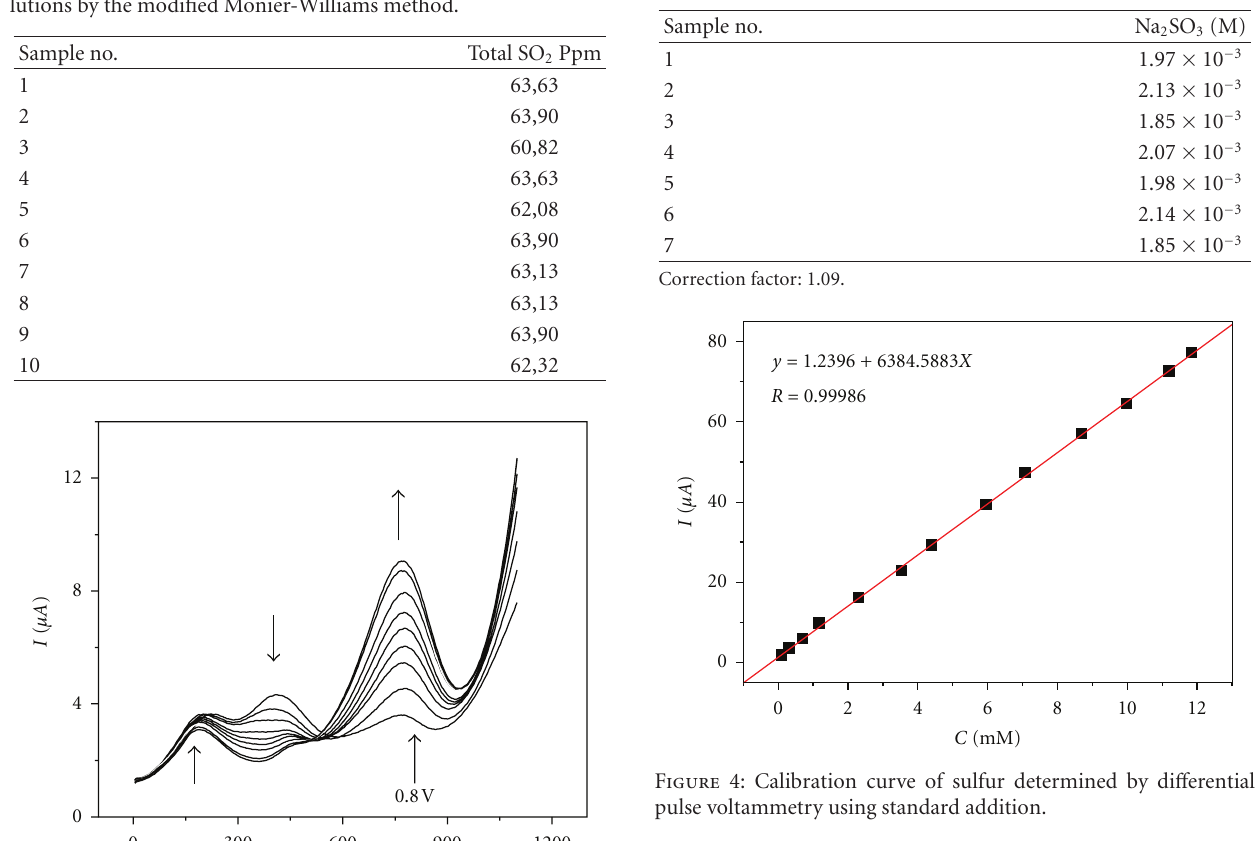
Table 3: Na 2 SO 3 determination by DPV.